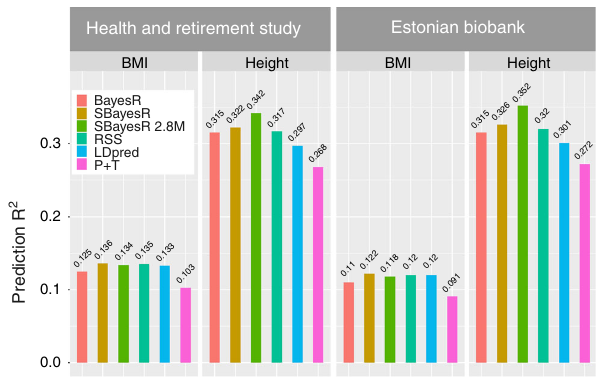
Fig. 3 Across-biobank prediction accuracy for height and BMI. Panels depict prediction R 2 ( y -axis) generated from regression of the predicted phenotype on the observed phenotype for BMI and height for different methods in the independent HRS and ESTB data sets. P + T refers to the prediction R 2 generated from the summary statistics of Yengo et al. 48 ( n ≈ 700,000), which included 6781 SNPs for BMI and 11,816 SNPs for height from a GCTA – COJO analysis thresholded at Wald test p value <0.001. The BayesR predictions were calculated by using 1,094,841 HM3 variants estimated from the full set of unrelated and related UKB European individuals ( n = 453,458 and n = 454,047 for BMI and height, respectively). Summary statistics for SBayesR 2.8 million variant (SBayesR 2.8M) analysis for the UKB European individuals were generated by using the BOLT-LMM software. All other prediction R 2 results were generated by using summary statistics methodology and were calculated from the analysis of summary statistics from Yengo et al. 48 for 909,293 and 932,969 variants for BMI and height that overlapped with the 1,094,841 HM3 variants set used for the UKB analyses. The overlap of the sets of variants used in each of the analyses and those available in the imputed HRS and ESTB data sets for prediction had a minimum value of 98%. Supplementary Table 1 details further the fi gure